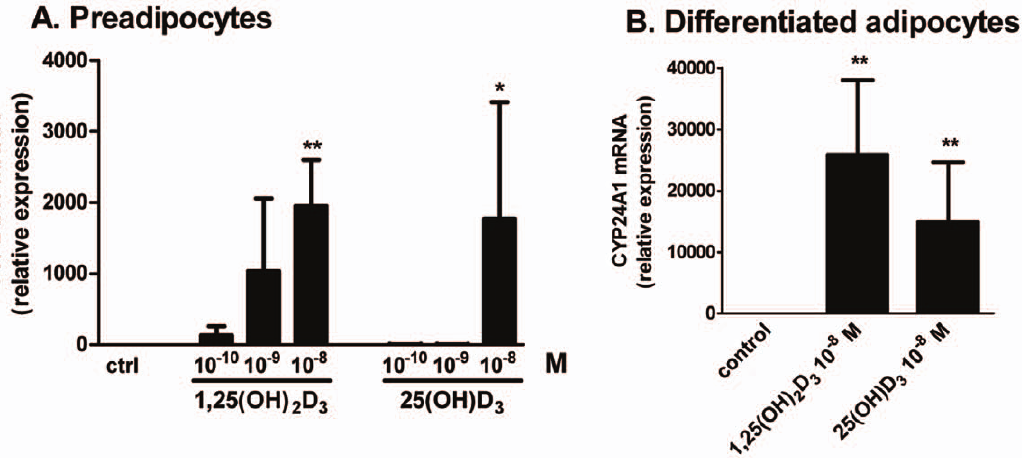
Figure 2. 1,25(OH) 2 D 3 and 25(OH)D 3 increased CYP24A1 mRNA in preadipocytes and newly-differentiated adipocytes. A. Preadipocytes were treated with vehicle control, 1,25(OH) 2 D 3 (10 2 10 , 10 2 9 , 10 2 8 M), or 25(OH)D 3 (10 2 10 , 10 2 9 , 10 2 8 M) for 24 h and CYP24A1 mRNA expression was measured (n=3). B. Differentiated adipocytes were treated with vehicle control, 1,25(OH) 2 D 3 (10 2 8 M), or 25(OH)D 3 (10 2 8 M) for 24 h and CYP24A1 mRNA expression was measured (n=5). **, p , 0.01, control vs.